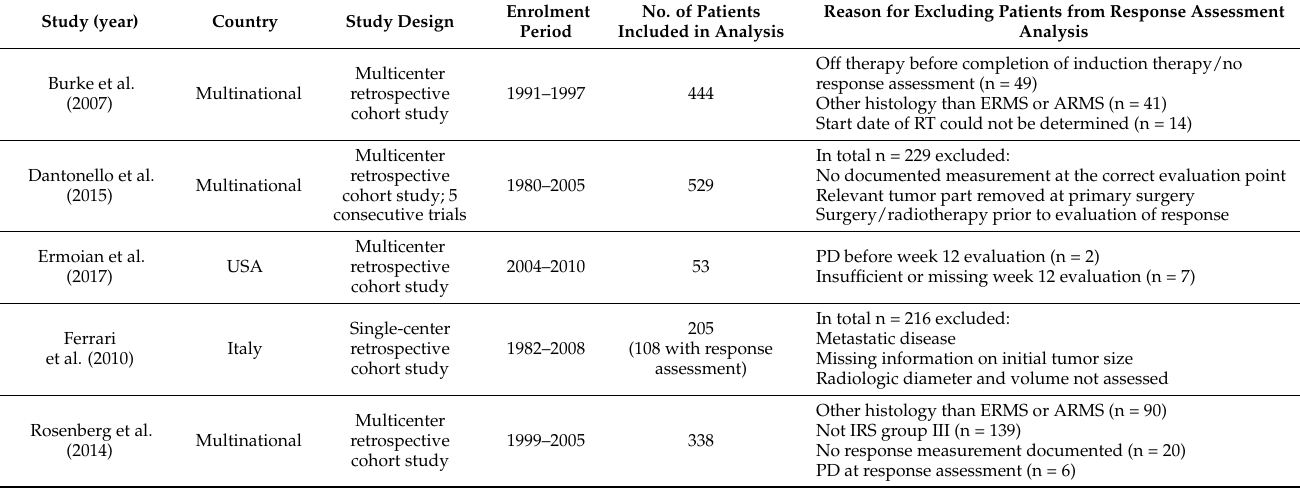
Table 1. Summary of the studies included in this systematic review.